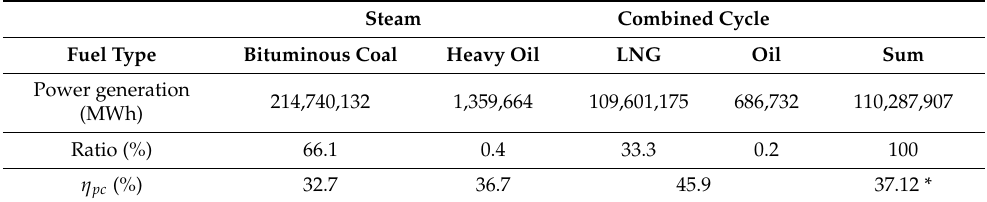
Table 2. Power generation by plant type and energy source [16].